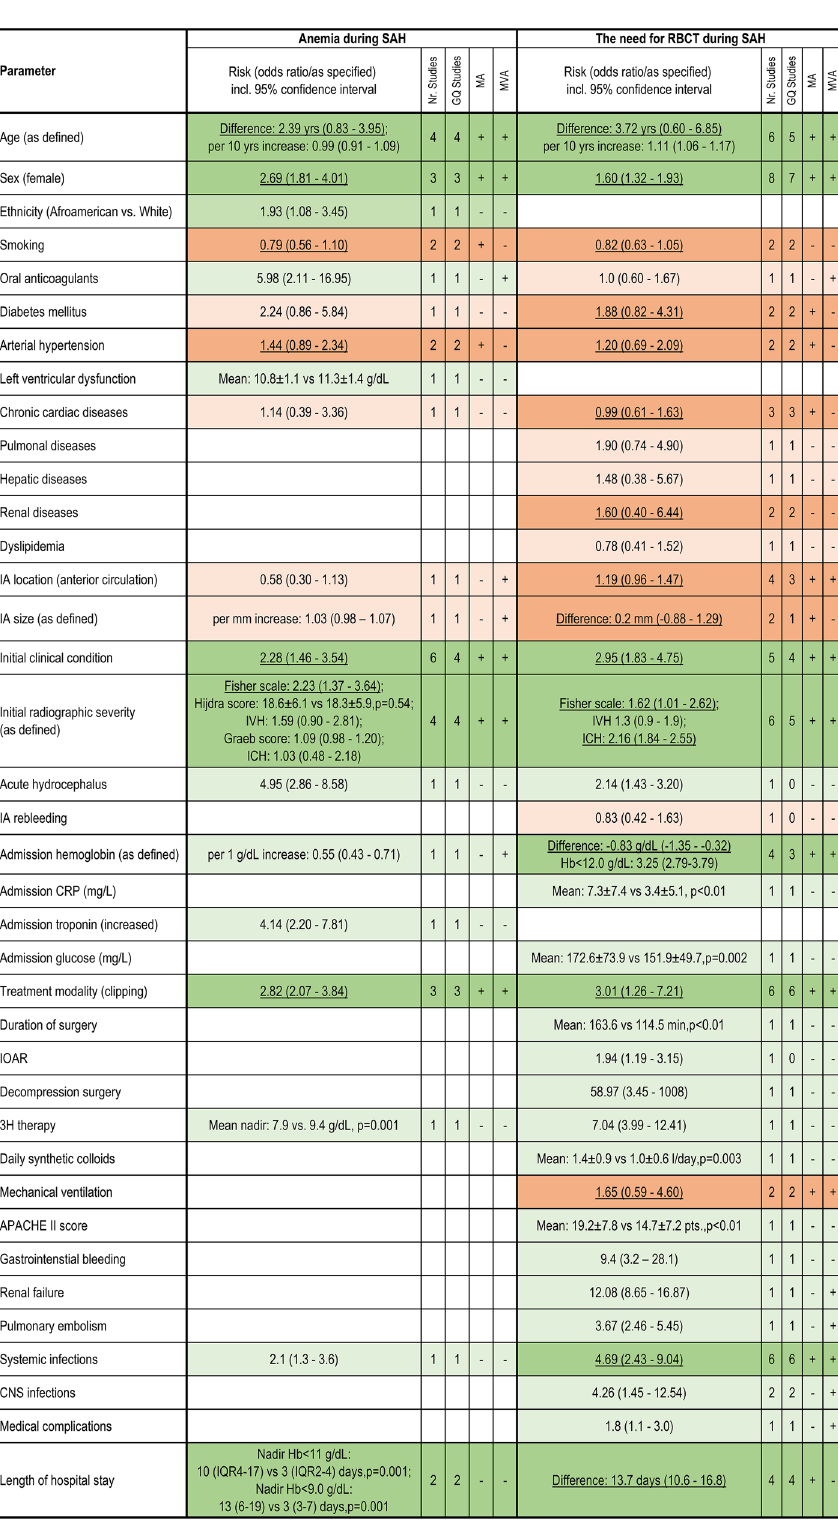
Figure 4. Summary overview of the evidence for the association between anemia and other study endpoints. The individual parameters are set out against the risk of developing anemia during SAH and the need for RBCT during the acute course. Correlations tested in multivariate analysis, the number of good-quality studies and the total number of studies included in the analyses are reported. Significant findings with sufficient (level I–II) und weak (level III–IV) evidence levels are marked in dark and light green, respectively. Fittingly, nonsignificant findings are marked dark (evidence level I–II) and light orange (lower evidence), respectively. SAH subarachnoid hemorrhage, Hb Hemoglobin, RBCT red blood cell transfusion, GQ good quality, MVA multivariate analysis, MA meta-analysis, CNS central nervous system, IOAR intraoperative aneurysm rupture, IA intracranial aneurysm, 3H-therapy triple H (hypervolemia, hypertension, hemodilution). The results depicted in the forest plot analyses are